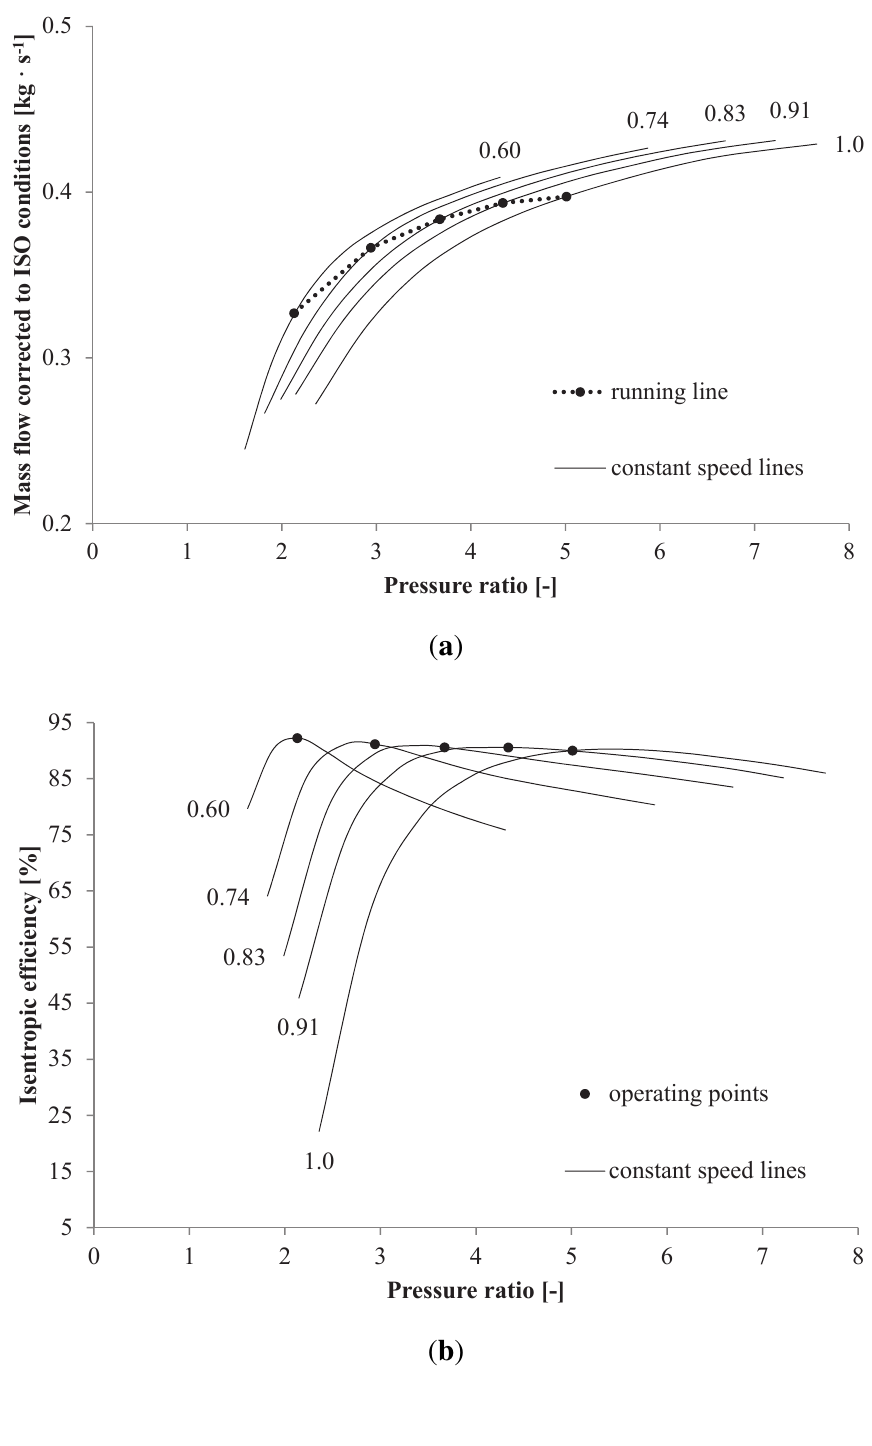
Figure 8. Turbine maps. The rotational speed is reported relative to the design-point value: ( a ) corrected mass flow as a function of the pressure ratio and the turbine operating points; and ( b ) isentropic efficiency as a function of the pressure ratio and the turbine operating